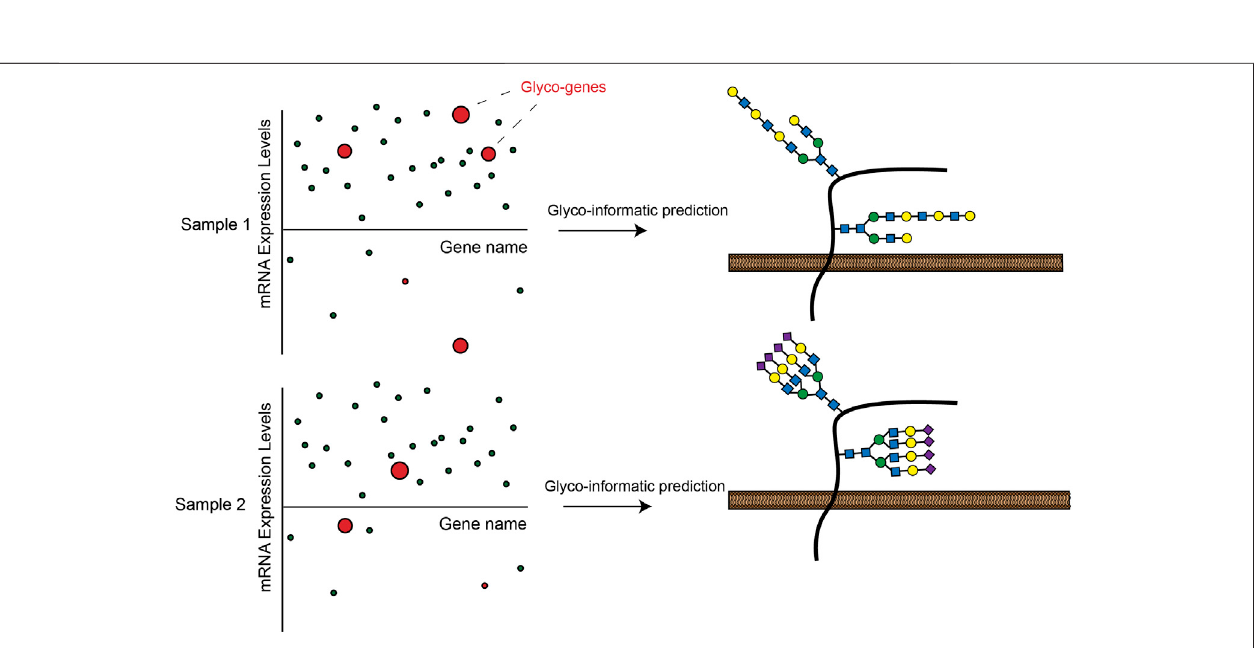
Frontiers in Molecular Biosciences |